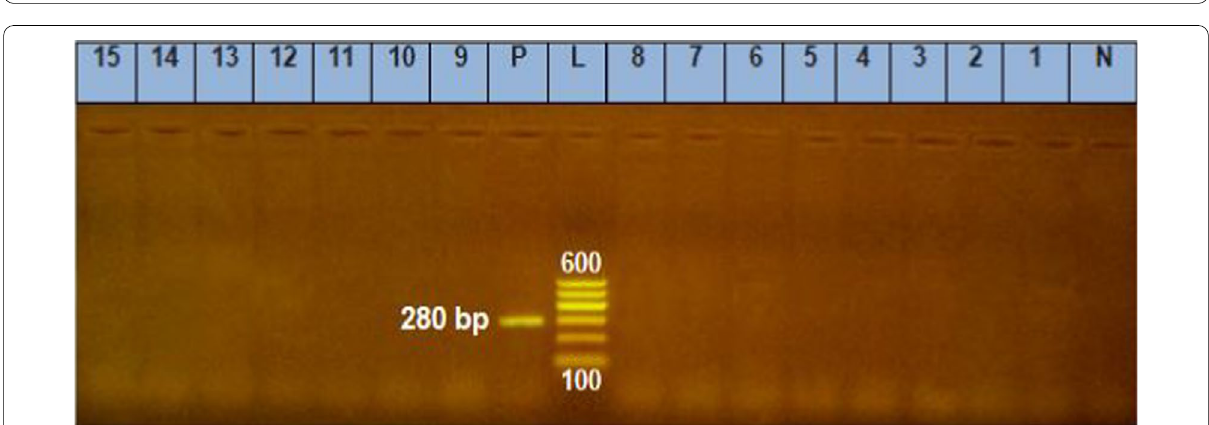
Fig. 6 Agarose gel electrophoresis showing amplification product of 593 bp of CTX-M . Lane L : Ladder (Marker) 100–1000 bp plus DNA ladder. Lane P : control positive. Lane N : control negative. Lane 1–15 : examined isolates